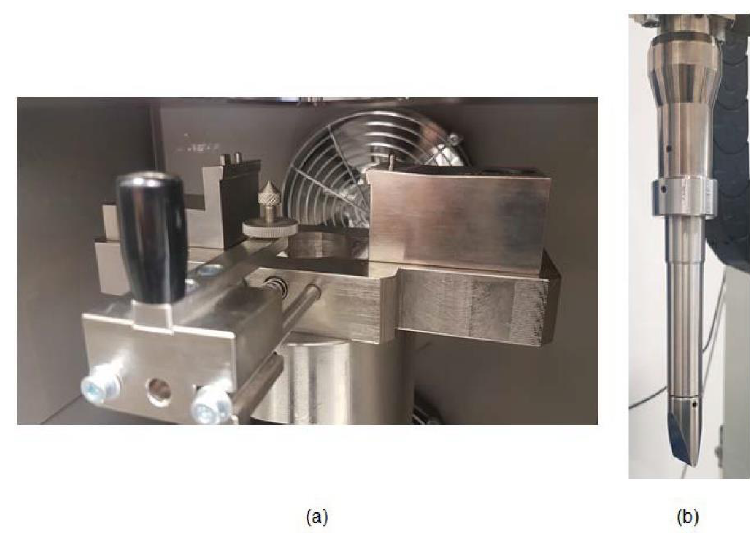
Figure 3. Details of the Charpy testing accessories according to ASTM D6110 used in the drop-weight column. ( a ) Charpy device support and ( b ) Charpy impactor (20 mm × 4 mm).